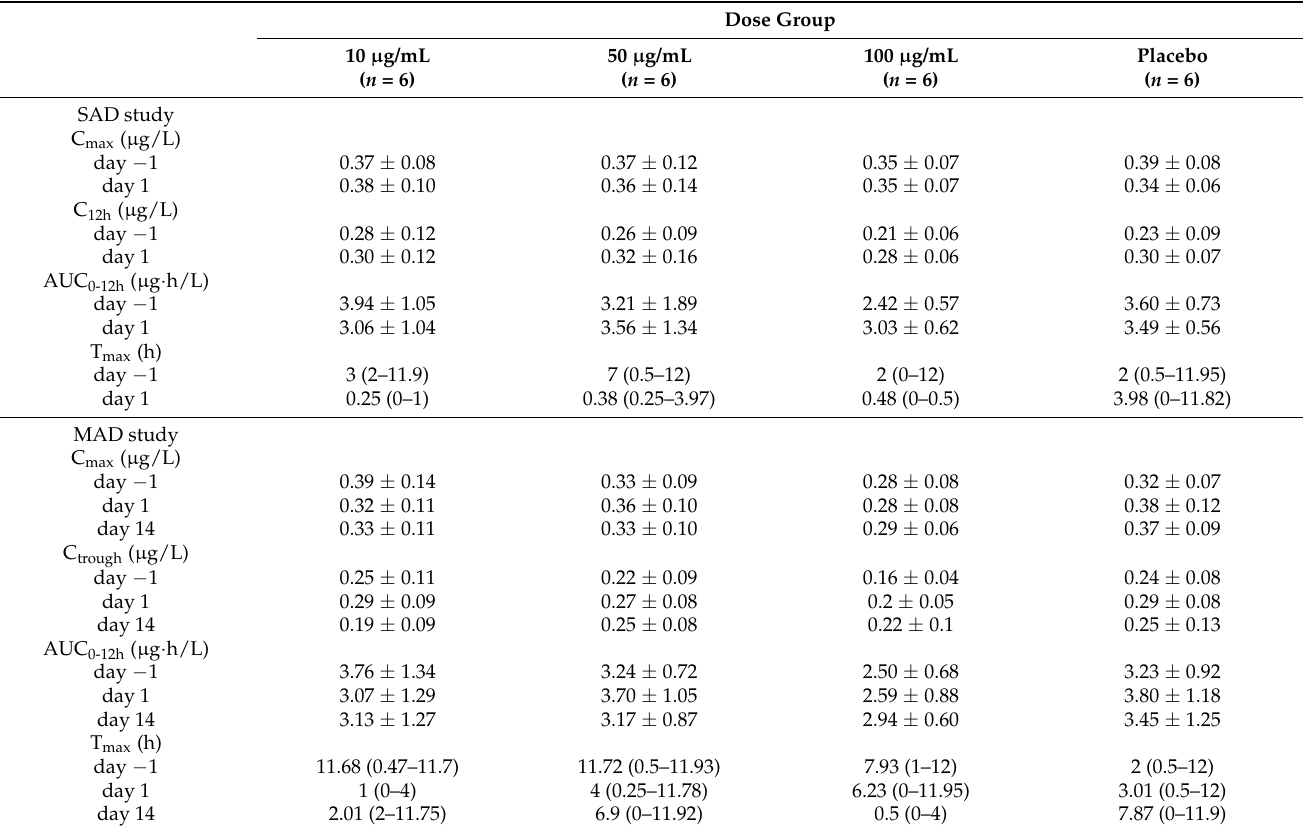
Table 2. Pharmacokinetic parameters of EGF in serum after single and multiple administration of rhEGF eyedrop.